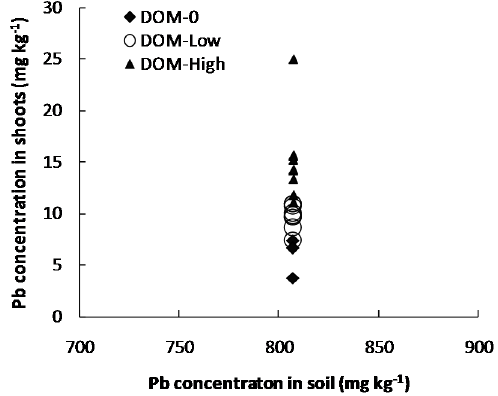
Figure 1. Pb concentrations in shoots of Brassica chinensis for different DOM (dissolved organic matter) levels. DOM-0, DOM-Low and DOM-High indicate DOM-free treatment, low dosage DOM treatment and high dosage DOM treatment, respectively.